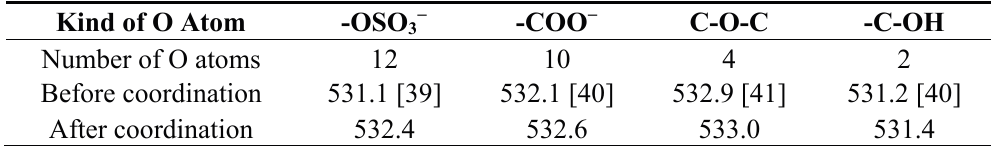
Figure 7. X-ray photoelectron spectra showing O 1s core level of various oxygen atoms in COM-HP compounds. Table 2. Core level binding energies of the O 1s photoelectron peaks of various oxygen atoms in COM-HP